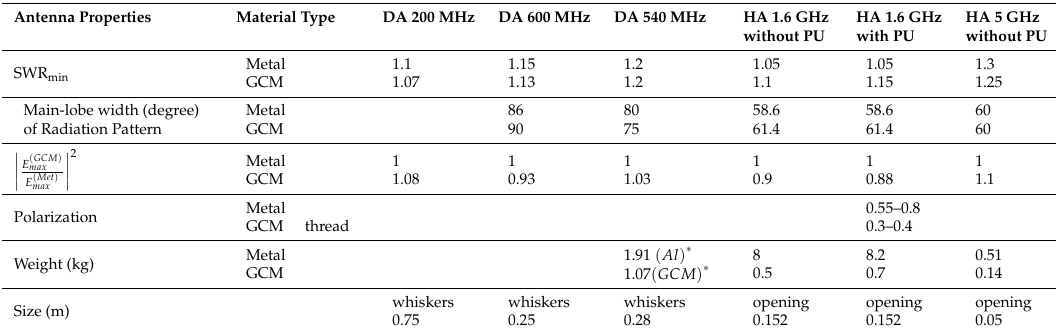
Table 1. Main antenna properties and parameters in the working frequency interval, for the composite prototype (with curricular winding of the fiber) and its metal analog (see Sections 3 and 4 for more details). DA: dipole antenna; HA: horn antenna; PU: polarization unit; E maximum values of the field amplitude of the emitted signal for the GCM prototype and its metal analog, respectively; the sign “*” denotes the weight of the reflector of the dipole antenna at 540 MHz; the reflector of dipole antennas at 200 MHz and 600 MHz are made from metal; the weight is indicated for GCM antennas manufactured in laboratory conditions (in industrial conditions it may be two times smaller).